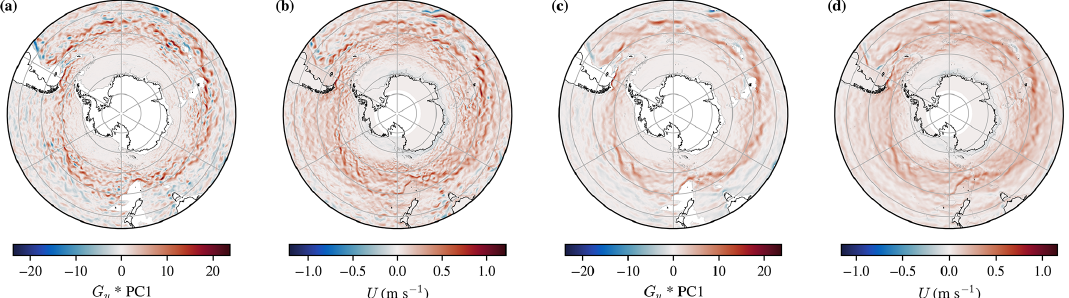
Figure A1. A comparison between the G x ∗ PC1 Sobel edge detection field and the zonal velocity, U , at 2m. Panels (a) and (b) are from the monthly mean over June 2011, whereas panels (c) and (d) are the mean over all of the monthly means in the dataset.